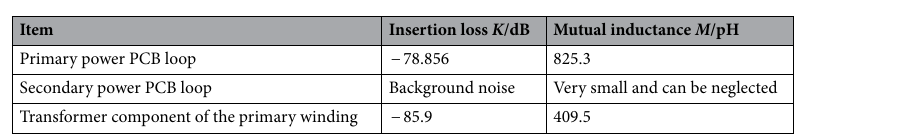
Table 1. Measurement results of mutual inductance.